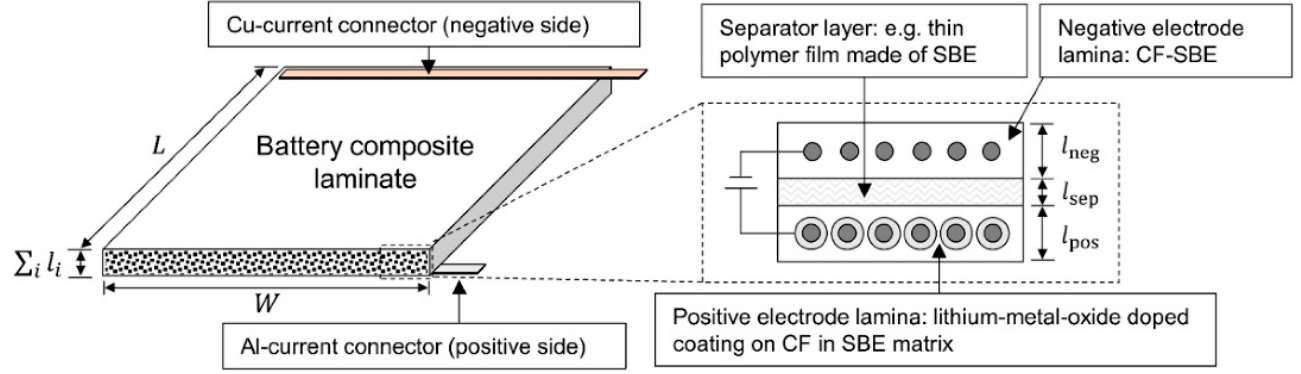
Figure 6. Example of a type ‐ IV structural battery concept [66].